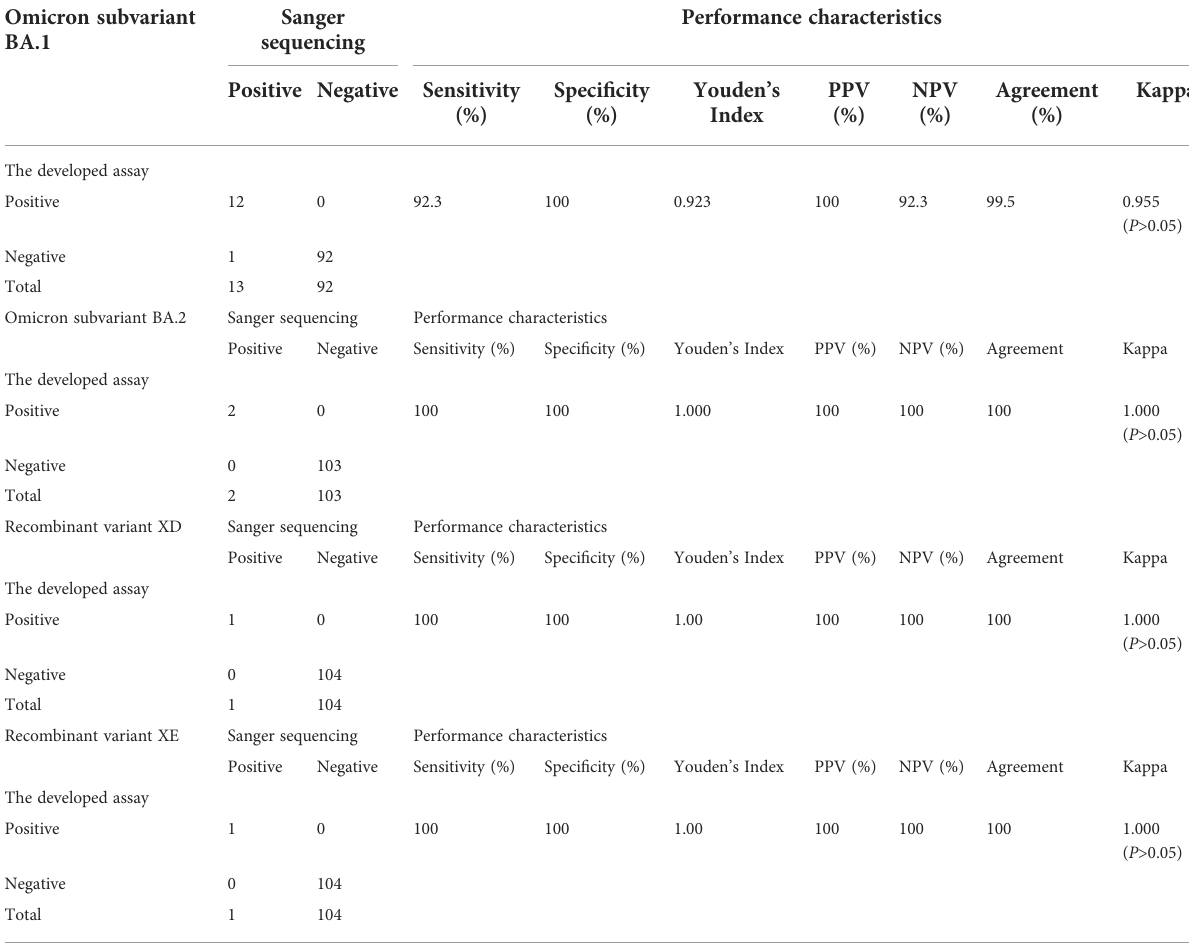
TABLE 5 Clinical performance of the developed multiplex qRT-PCR assays for Omicron subvariants (BA.1 and BA.2) and recombinant variants (XD and XE) of SARS-CoV-2. Omicron